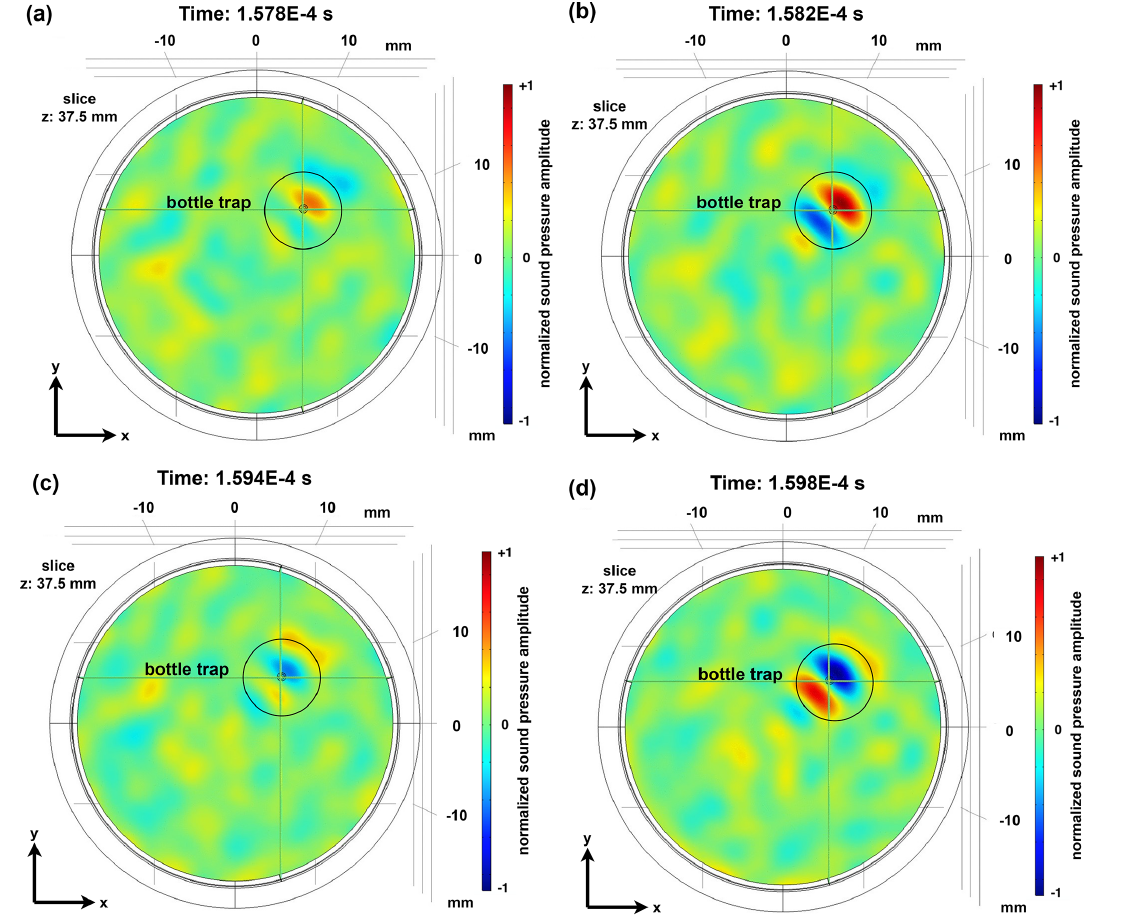
Figure A1. Intensity plot of the acoustic pressure field of the bottle trap during the focusing process in the x – y plane in the cylindrical vessel during four different